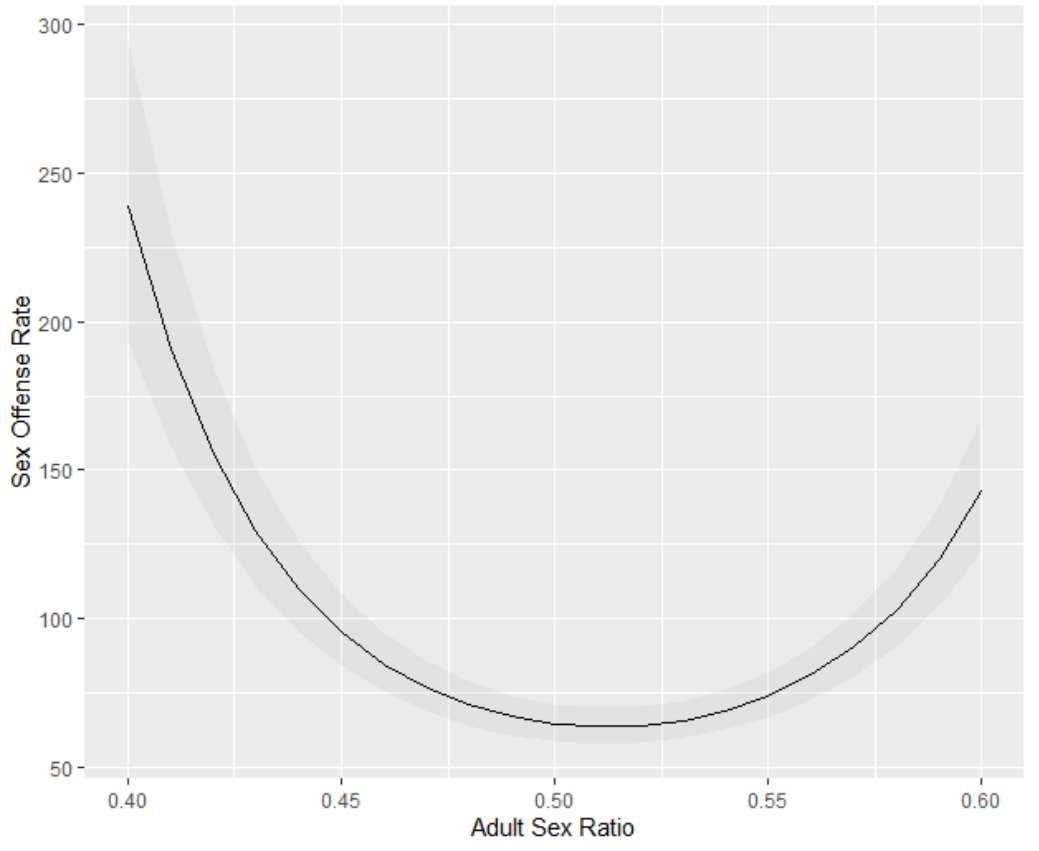
Figure 1. Predicted sex offense rate based on the adult sex ratio (with 95% Confidence Interval). Table 2 depicts the negative binomial regression coefficients and includes the quadratic term when modeling the sex offense rate for the age group 15 to 44. An ANOVA test confirmed including the quadratic term improved the fit of the model, X 2 (1) = 261.27, p < 0.001. In the full model, all of the independent variables were statistically significant.